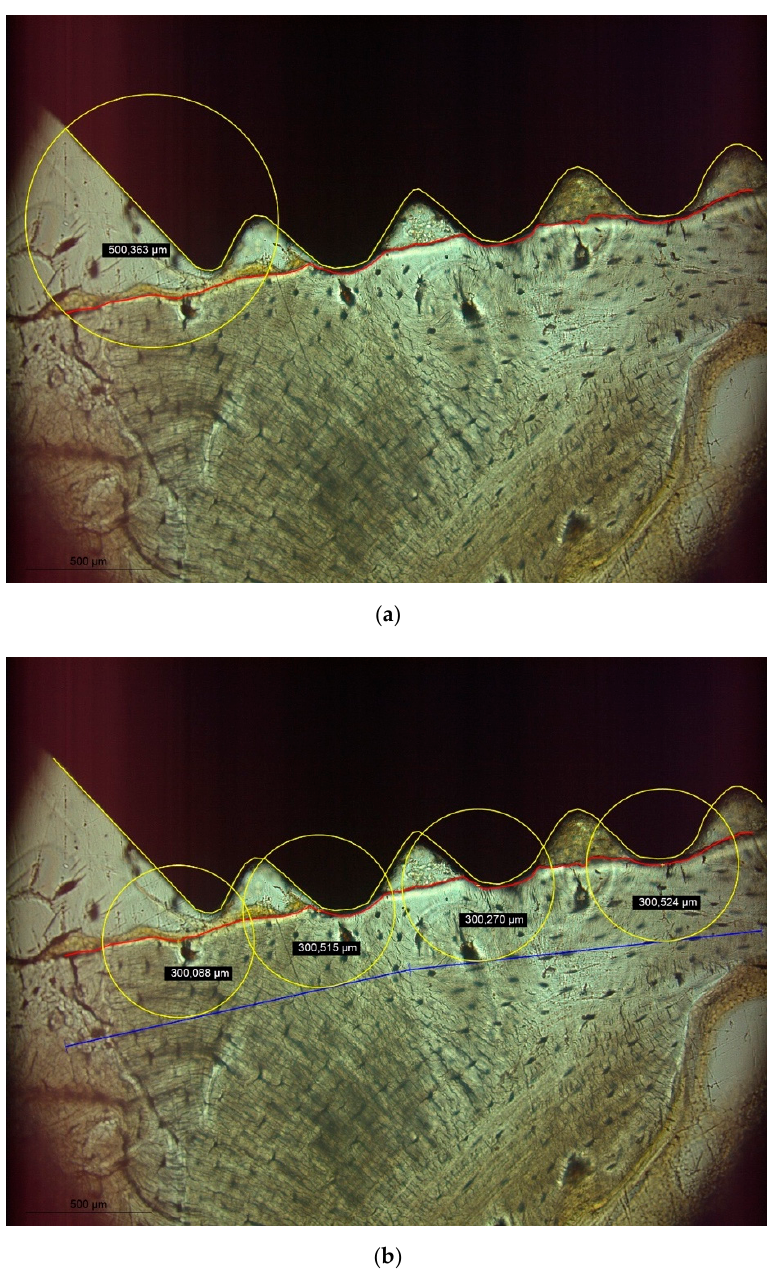
Figure 4. ( a ) BIC was defined as bone being present within a radius of 500 µm surrounding a specific point of the implant surface (yellow line). ( b ) The bony walls of the implant socket were identified (red line) and a radius of 300 µm surrounding a specific point of the bony socket was defined as region of interest for determining bone damage.